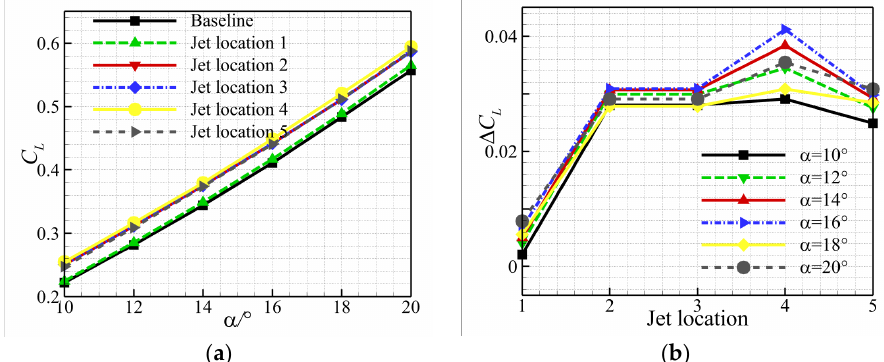
Figure 10. Changes in lift by the lateral jets at different jet locations. ( a ) Lift coefficient; ( b ) Lift coefficient augmentation.